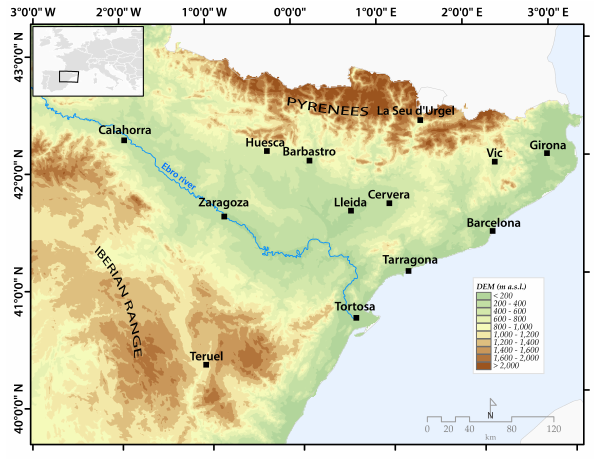
Figure 1. Locations of the historical documents in the northeast of